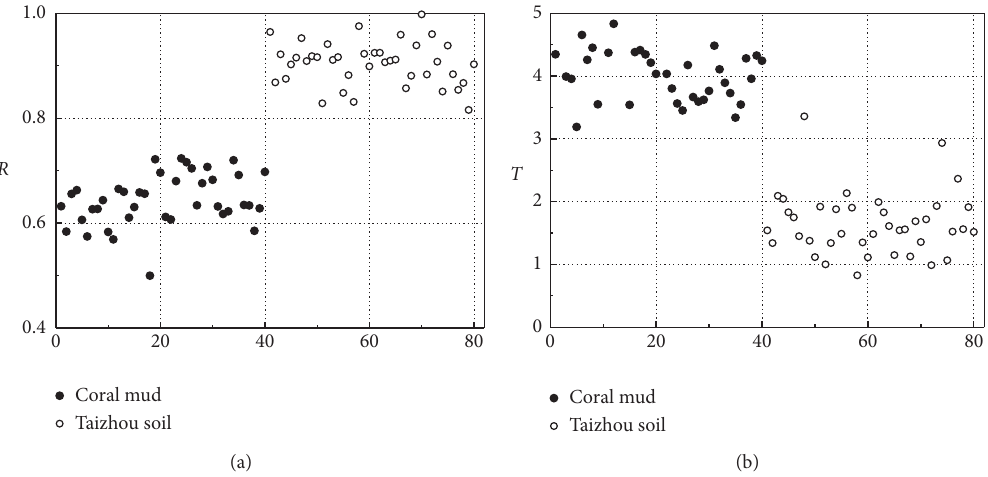
Figure 4: Shape parameters of the testing materials: (a) circular degree and (b) ring diameter